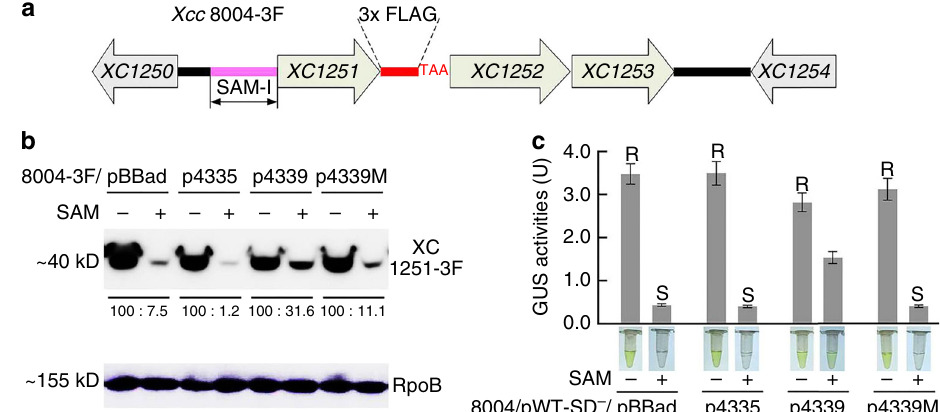
Fig. 5 Derepression of SAM ’ s inhibitory effect by over-expression of tRNA fMet . a The genetic organization of the met operon locus in the recombinant strain Xcc 8004-3F. A 3xFLAG-tag and a stop codon (TAA) were inserted between XC1251 and XC1252 to monitor the expression of XC1251. b Western blot detection of XC1251-3F in strain Xcc 8004-3F carrying different plasmids. The culture was grown in MMX alone (SAM − ) or MMX supplemented with 2.5 µ M SAM (SAM + ). pBBad: an expression vector; p4335, p4339, and p4339M: the recombinant pBBad expressing tRNA Met1 , tRNA fMet , and tRNA fMet mutant (73U74A → 73A74U) that lost the binding ability with SAM-I Xcc , respectively. RNA polymerase β sub-unit (RpoB) protein was used as a control. c Plot of GUS activities produced by the reporter strain 8004/pWT-SD − carrying the series of plasmids in b in response to SAM. The culture was grown in MMX alone (SAM − ) or MMX supplemented with 250 µ M SAM (SAM + ). Data are presented as mean values ± SD from three biologically independent samples. Different letters above the columns represent the signi fi cant difference at P < 0.05 by Student ’ s two-tailed t -test. Columns marked with the same letter are not signi fi cantly different from one another. Representatives of colorimetric samples for each condition were also included in the graph. Source data are provided as a Source Data fi